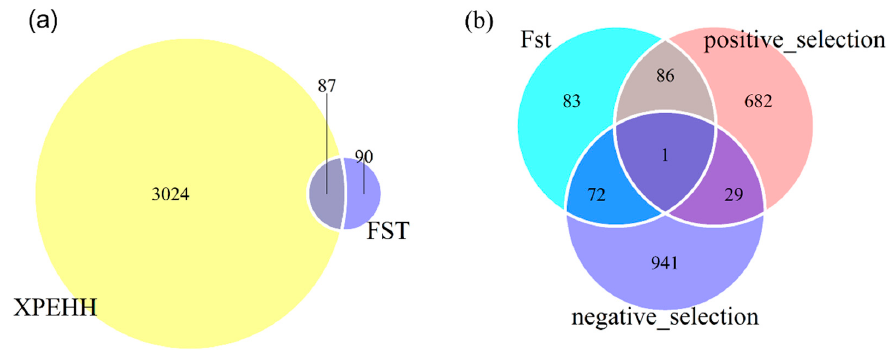
Figure 4. Venn plots represent: ( a ) The common selection signatures obtained by Fst and XPEHH test; ( b ) the genes under selection in three population pairs.